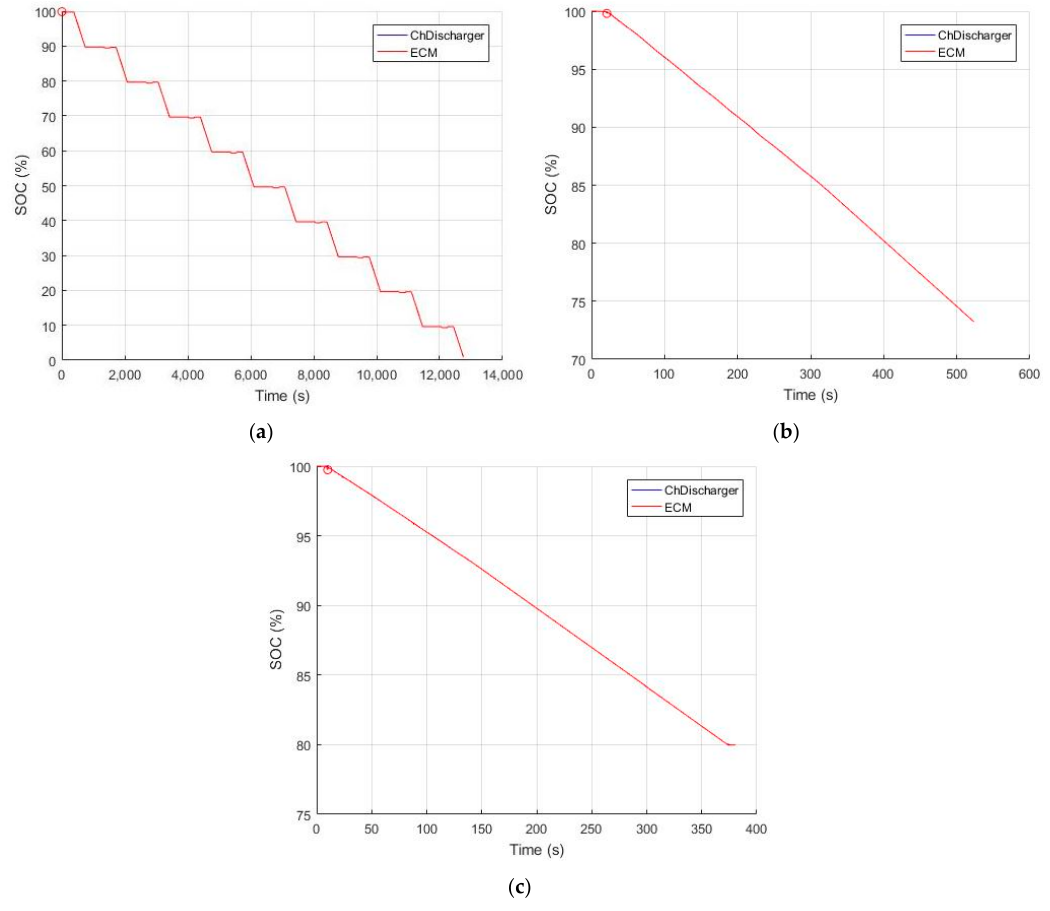
Figure 8. The SOC comparison result (w/EKF and K soc = 1): ( a ) HPPC; ( b ) 0 kg payload; and ( c ) 10 kg payload. Table 1. Indoor test result (HPPC).